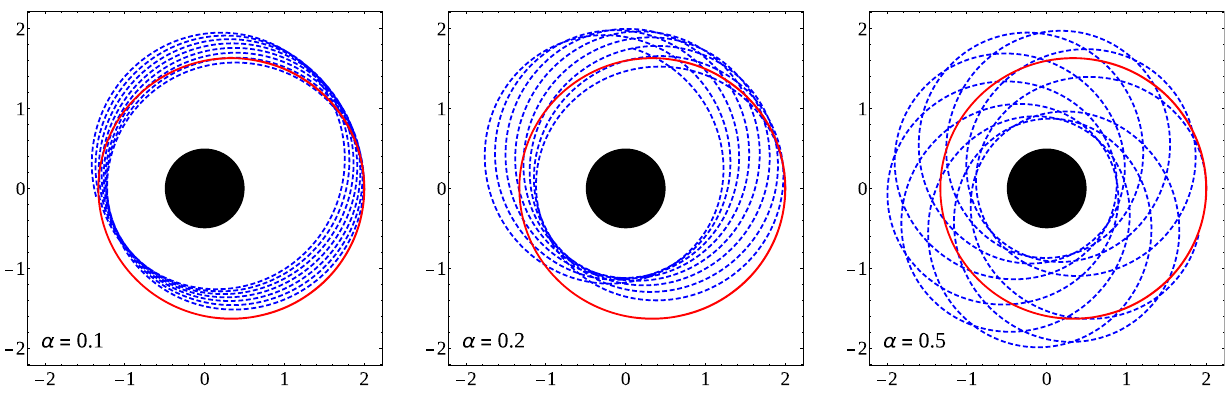
μ m, and α = 0 . 1 (left panel), α = 0 . 2 (middle panel) and α = 0 . 5 (right panel). The initial conditions are: k = G N m P /λ 3 = 10 − 3 s − 2